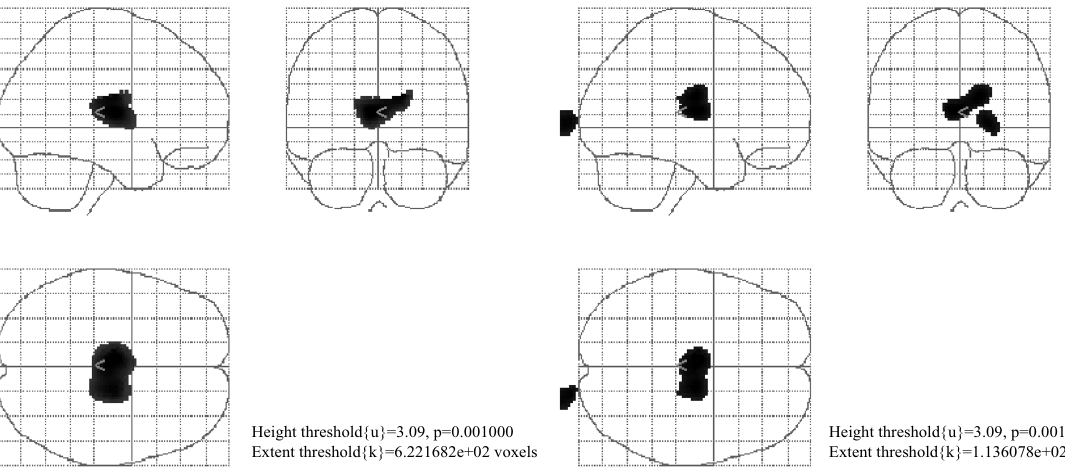
Fig. 3. SPM results comparing patients with aneurysms at sites other than ACoA with control subjects; Fig. 3(a)(left): whole brain normalisation, Fig. 3(b)(right): cerebellar normalisation. The figures illustrate the orthogonal maximum intensity projections of the thresholded statistical parametric map. The map is thresholded at an individual voxel value of 3 . 09 ( p = 0 . 001 ) and clusters of voxels having a probability of chance occurrence of < 0 . 001 , when corrected for multiple comparisons, are displayed.